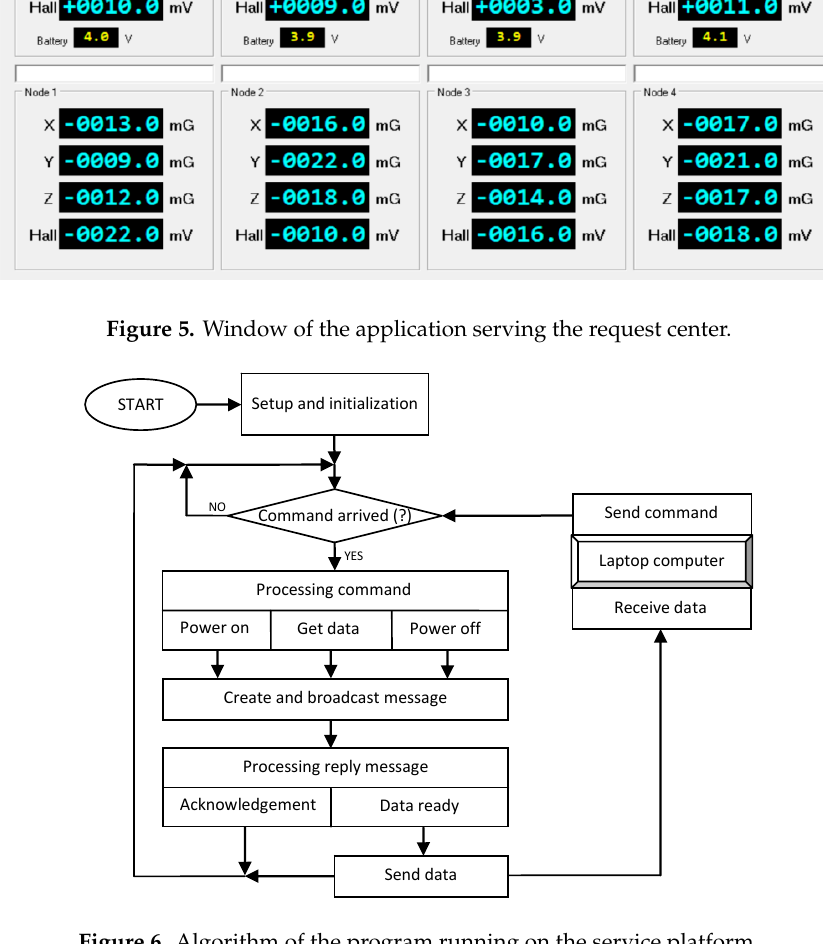
Figure 6. Algorithm of the program running on the service platform.